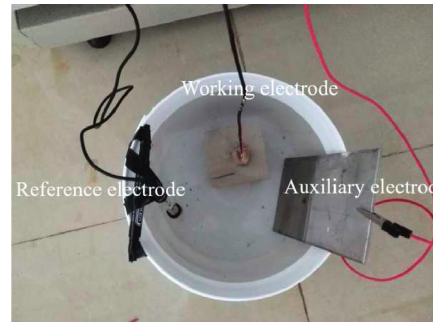
Figure 7: The three-electrode testing method.